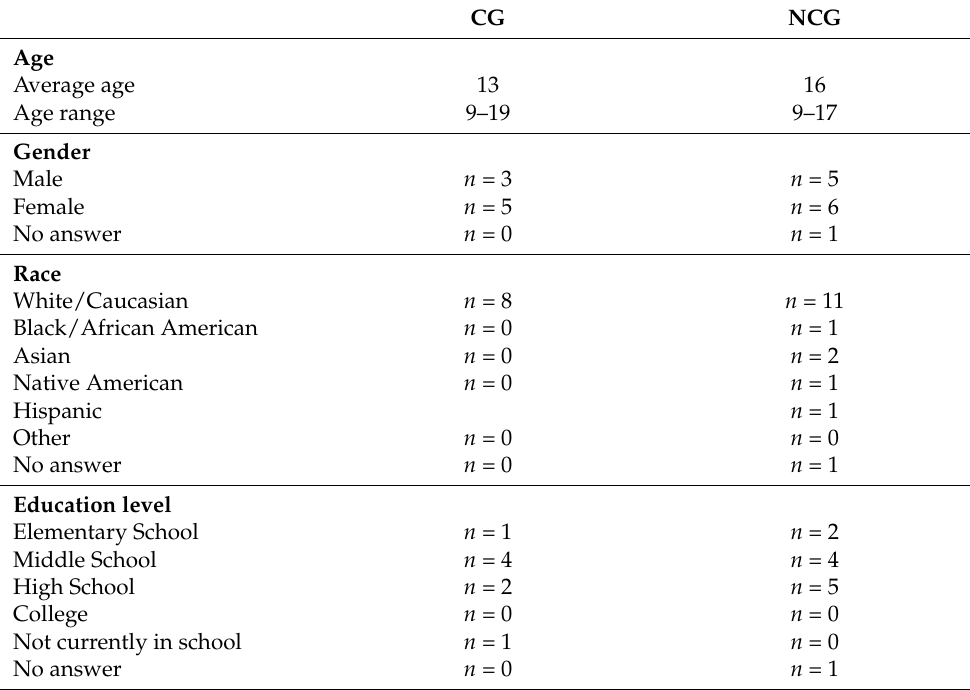
Table 1. Descriptive statistics.